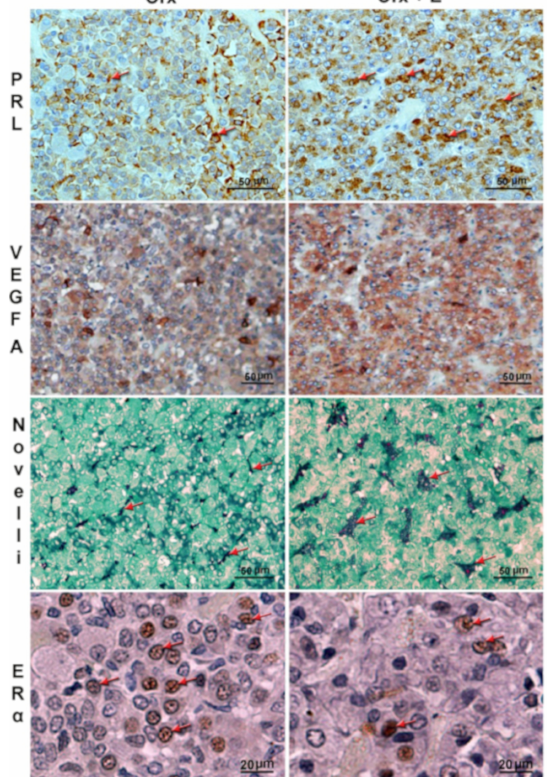
Figure 2. Representative micrographs of immunohistochemically (IHC) or histochemically stained anterior pituitary sections of orchidectomized (Orx) and estradiol-treated orchidectomized (Orx + E) middle-aged rats. Hypertrophy and hyperplasia of prolactin-immunopositive cells (PRL, red arrows; adopted from our previous publication [55] and reprinted by permission of the Licensors - publishers Elsevier (Licence number 4774000297301)), stronger vascular endothelial growth factor A (VEGFA) immunopositivity, more abundant blood vessels (red arrows, Novelli histochemical staining) and lower nuclear estrogen receptor α immunopositivity (red arrows, ER α ), respectively, are observable after estradiol treatment. Micrographs were obtained according to the same procedures